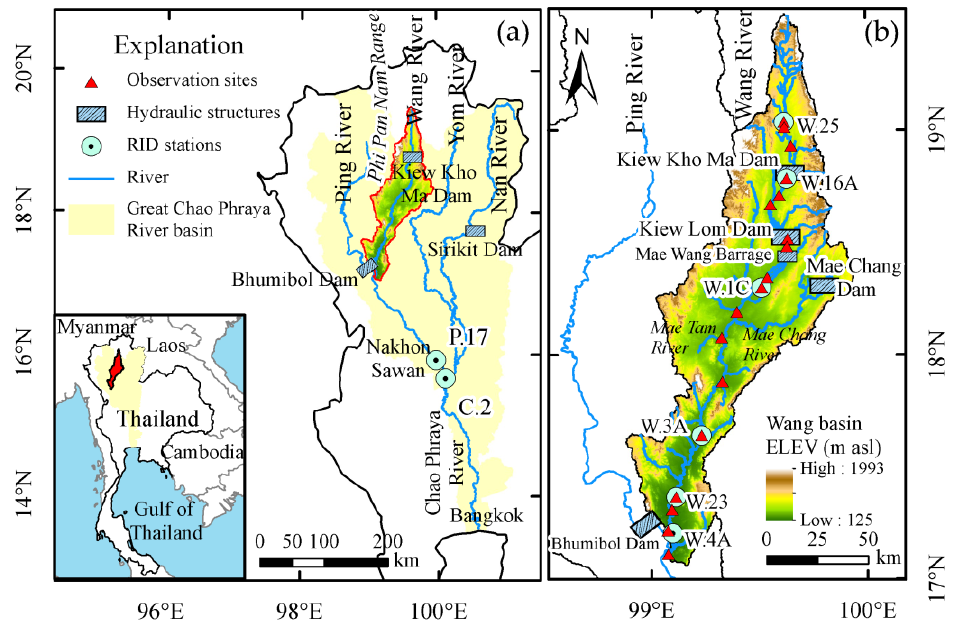
Figure 1. Map of the Chao Phraya River Basin, Thailand: ( a ) Wang River Basin and location of dams in the Chao Phraya River system; ( b ) locations of hydrological stations operated by the Royal Irrigation Department (RID) and observation sites in this study.